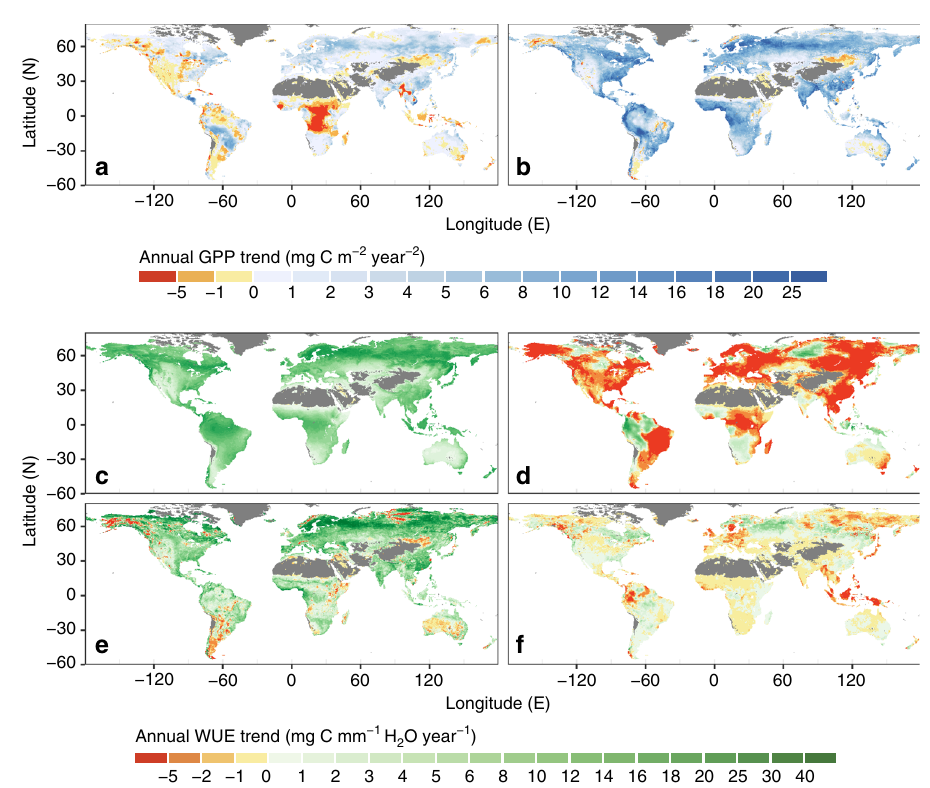
Fig. 4 Estimated spatial variations of the contributions to trends of ecosystem gross primary production (GPP) and water use ef fi ciency (WUE) from different variables over 1982 – 2011. a , b Spatial details of the contributions to recent trend in GPP from ecosystem water use and WUE in g C m − 2 per year 2 , respectively. c – f Spatial details of the contributions to trends in ecosystem WUE atmospheric CO 2 concentration c , vapour pressure de fi cit d , leaf area index e and fraction of canopy interception in mg C mm − 1 H 2 O per year